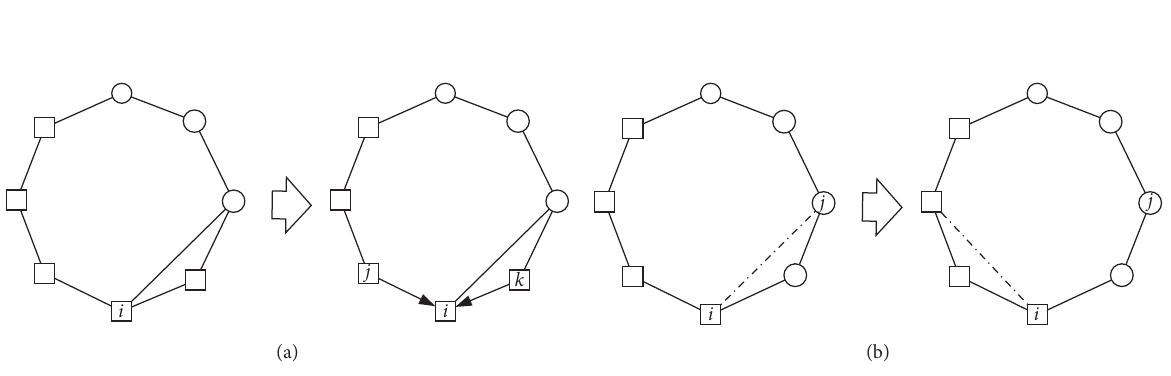
Figure 3: CA mechanism and SU mechanism at time t with node shapes representing states. At each time step, the system is updated according to the process illustrated in (a) or (b) with a precondition of the number of homogeneous (heterogeneous) neighbor nodes. When the number of homogeneous neighbor nodes of v i is greater than that of heterogeneous neighbor nodes, as shown in (a), the state of v i will be affected by its two homogeneous neighbor nodes. The direction of the arrow indicates the direction in which neighbor nodes influence it. Otherwise, as shown in (b), v i will randomly select a node and achieve a rewiring process.